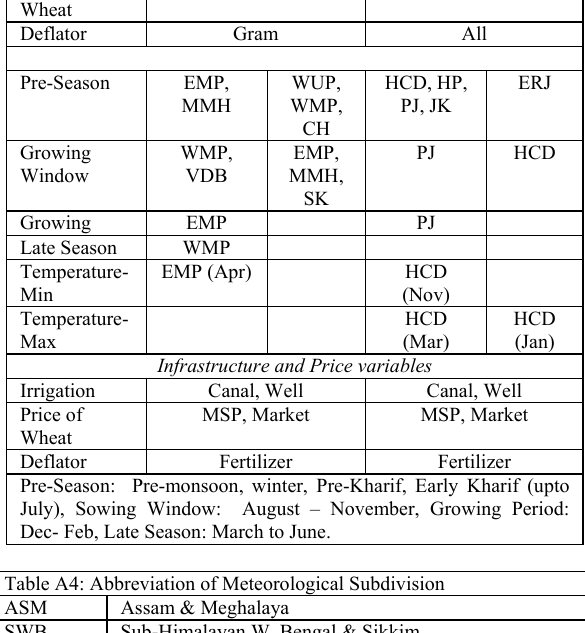
Table A4: Abbreviation of Meteorological Subdivision ASM Assam & Meghalaya